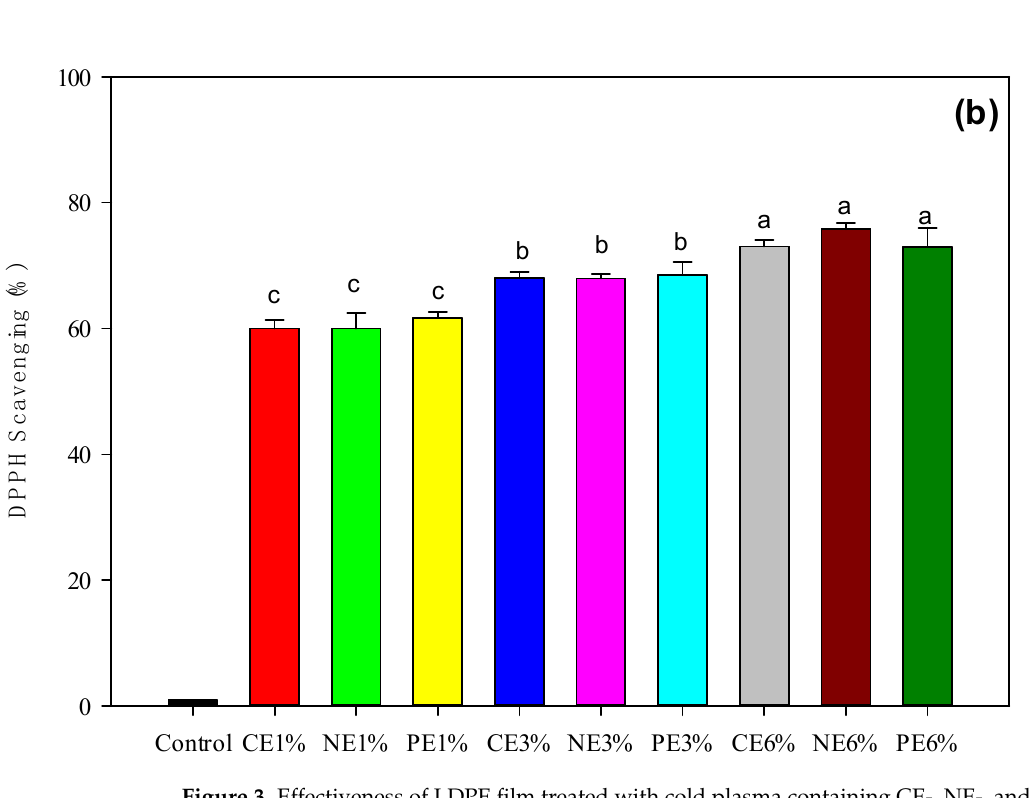
Figure 3. Effectiveness of LDPE film treated with cold plasma containing CE-, NE-, and PE-stabilized MFEO. ( a ) Total phenolic content; ( b ) antioxidant activity through the DPPH radical scavenging assay. a–c The values with different superscripts are significantly different at p < 0.05. The error bars represent the standard deviations ( n = 3).